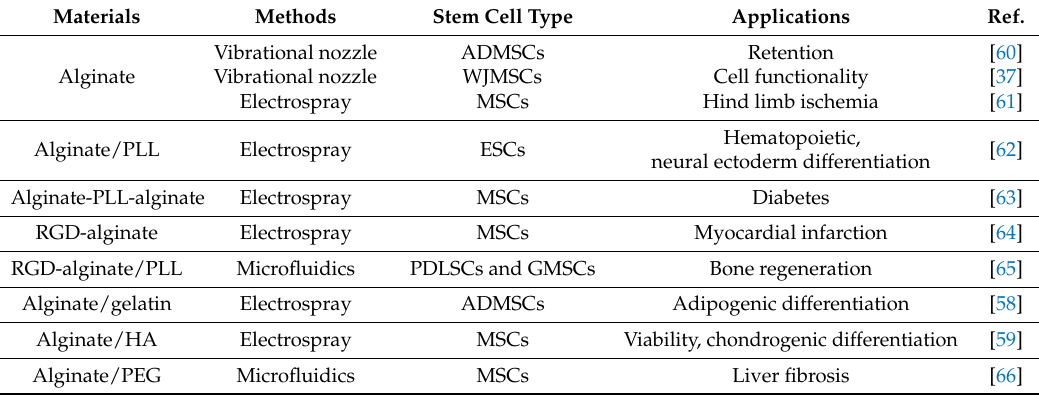
Table 1. Examples of alginate-based stem cell